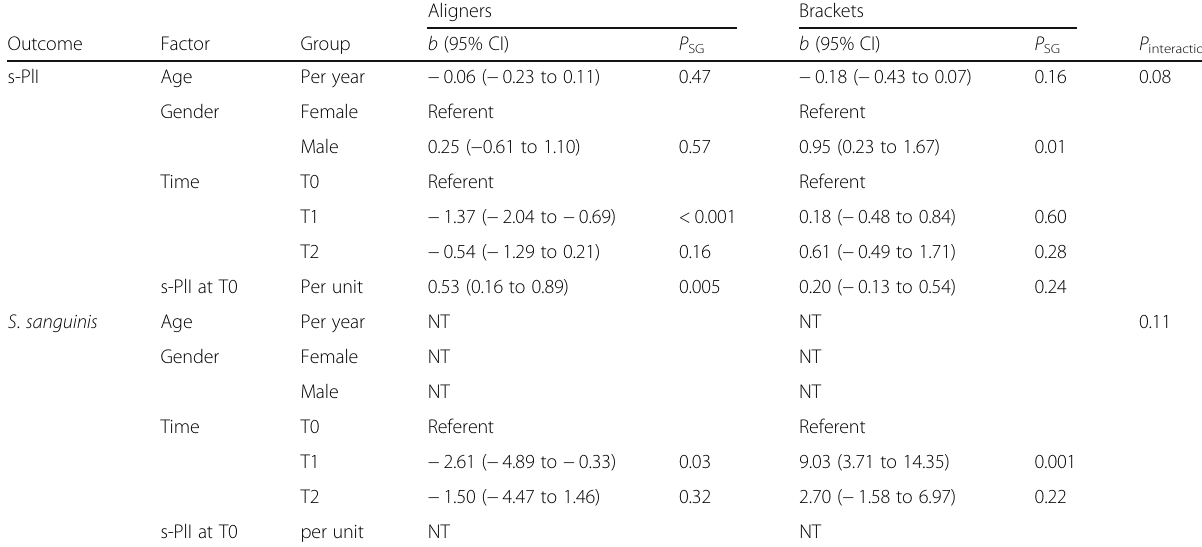
Table 7 Explorative regression analyses with simplified plaque index or S . sanguinis counts as dependent variable and stratified by appliance